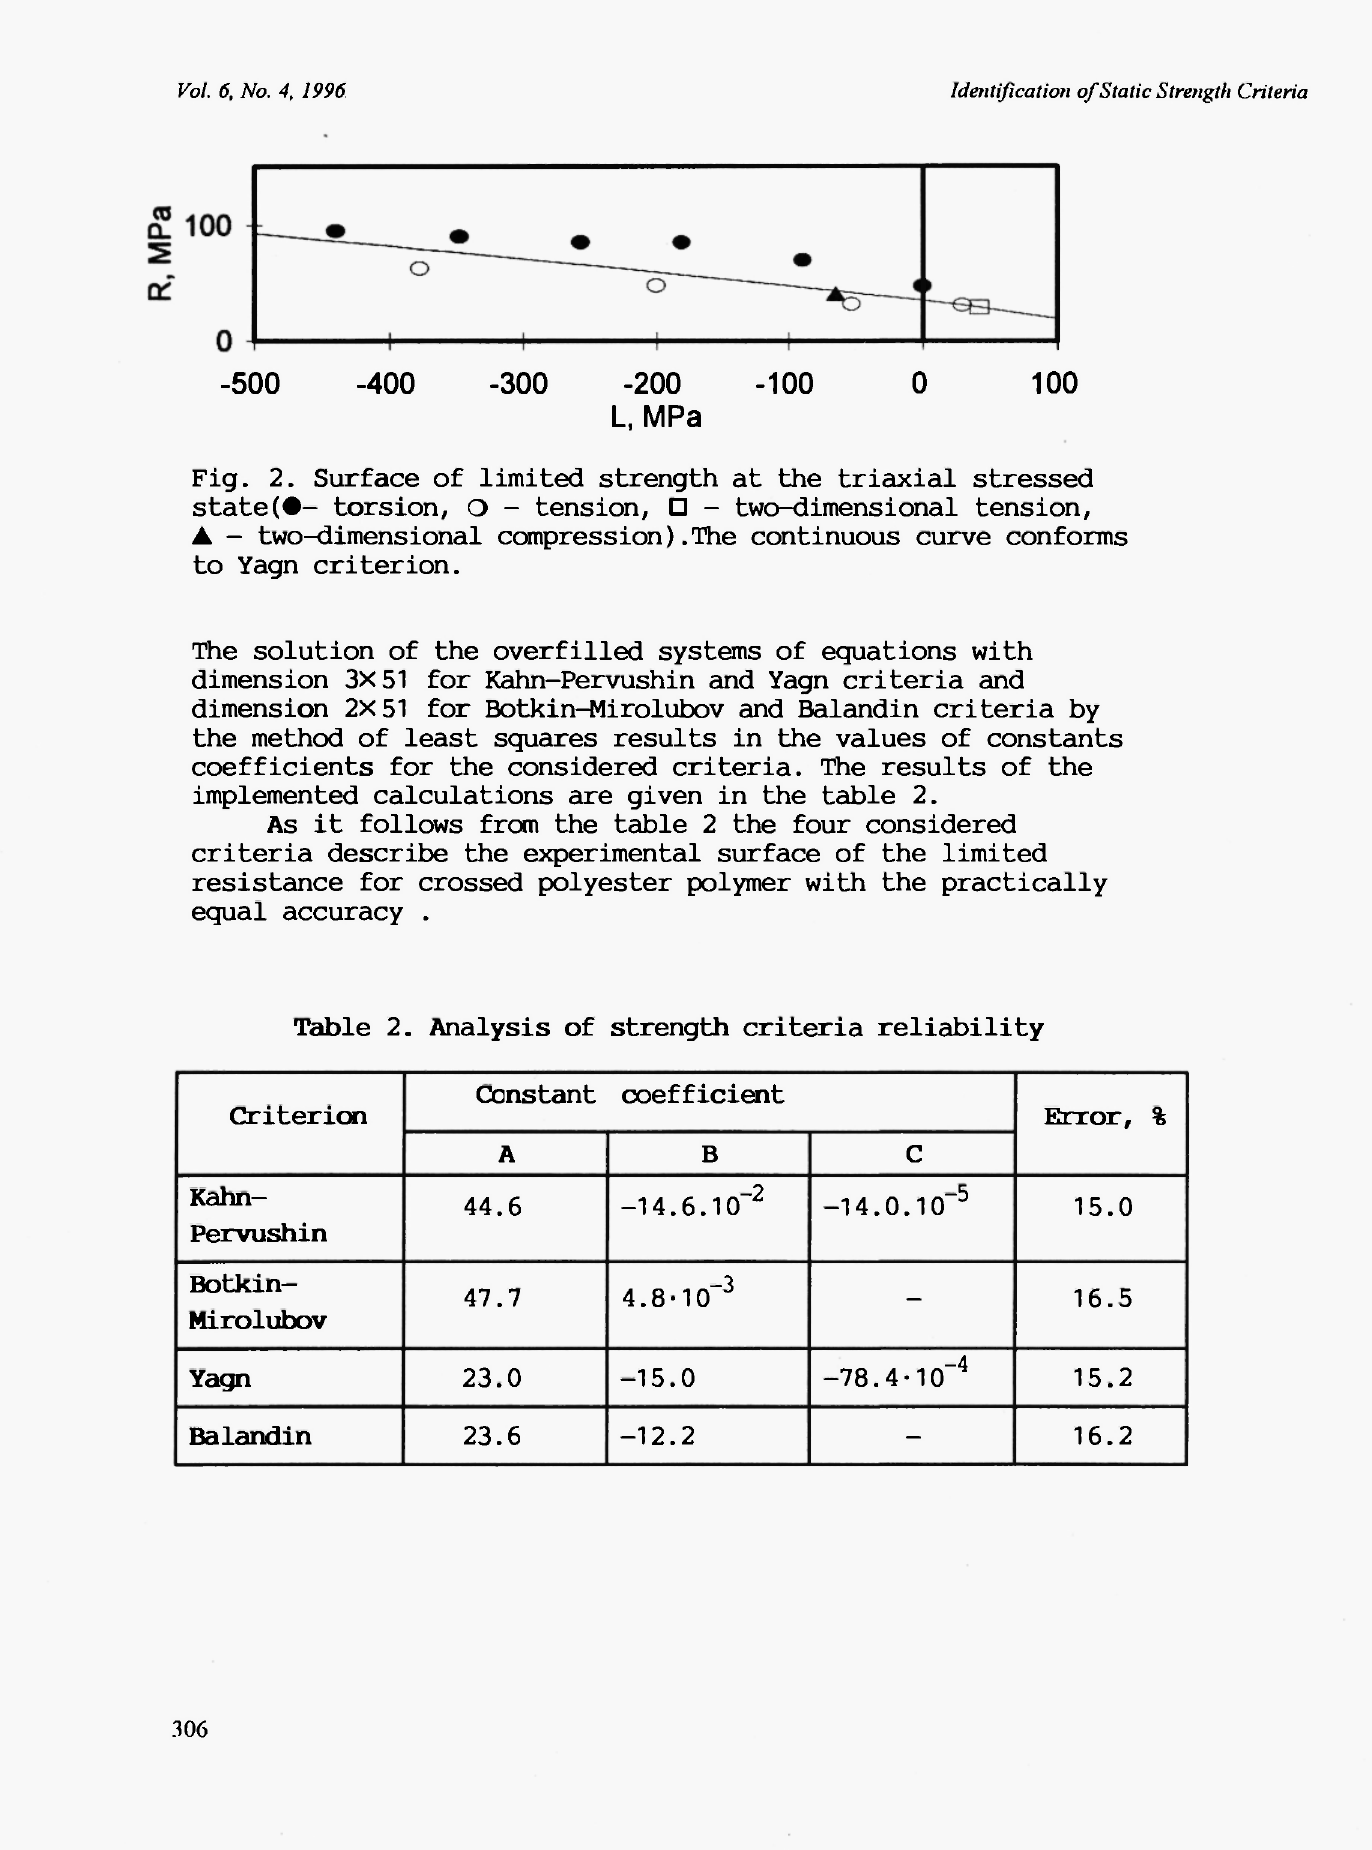
Table 2. Analysis of strength criteria